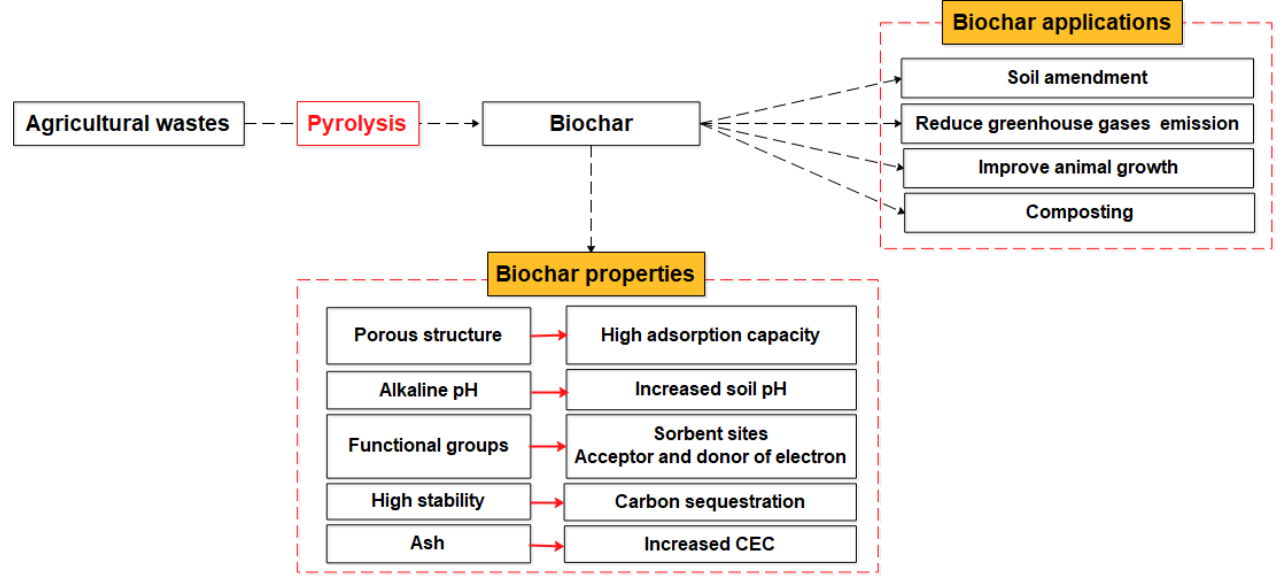
Figure 1. Overview of biochar properties and different forms of its agricultural application.